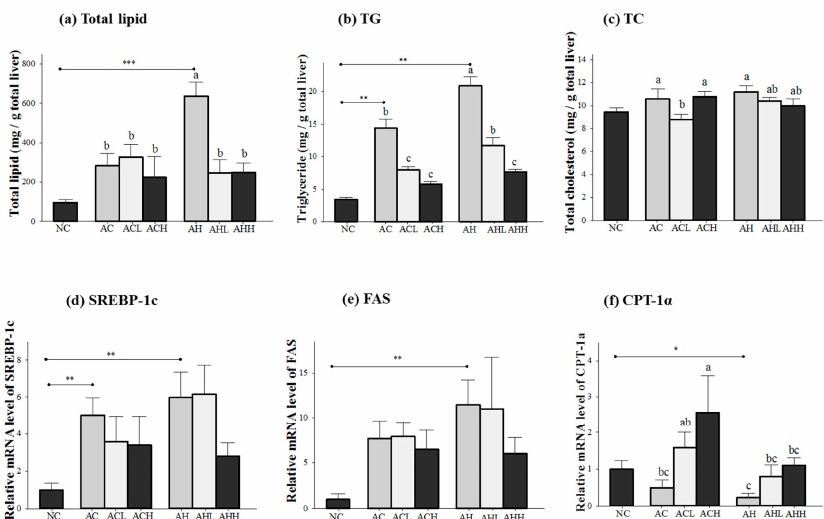
Figure 2. Effects of AK on hepatic lipid metabolism in C57BL/6J mice fed with alcohol and HFD: ( a ) total lipid; ( b ) TG; ( c ) TC; ( d ) SREBP-1c; ( e ) FAS, and ( f ) CPT-1 α . Each value is expressed as the mean ± S.E. NC, normal control; AC, alcohol control; ACL, low-dose (1%) AK in alcohol group; ACH, high dose (3%) AK in alcohol group; AHC, alcohol/HFD control; AHL, low-dose AK in alcohol/HFD group; and AHH, high-dose AK in alcohol/HFD group. AK, ethanolic extract of Acanthopanax koreanum Nakai; HFD, high fat diet; TG, triacylglycerol, TC, total cholesterol; SREBP-1c, sterol regulatory element-binding protein-1c; FAS, fatty acid synthase; CPT-1 α , carnitine palmitoyltransferase 1 α . Mean bars with different alphabets are significantly different among alcohol ingestion groups at p < 0.05 with Duncan’s multiple comparison tests. * p < 0.05, ** p < 0.01 and *** p < 0.001 (AC and AH to